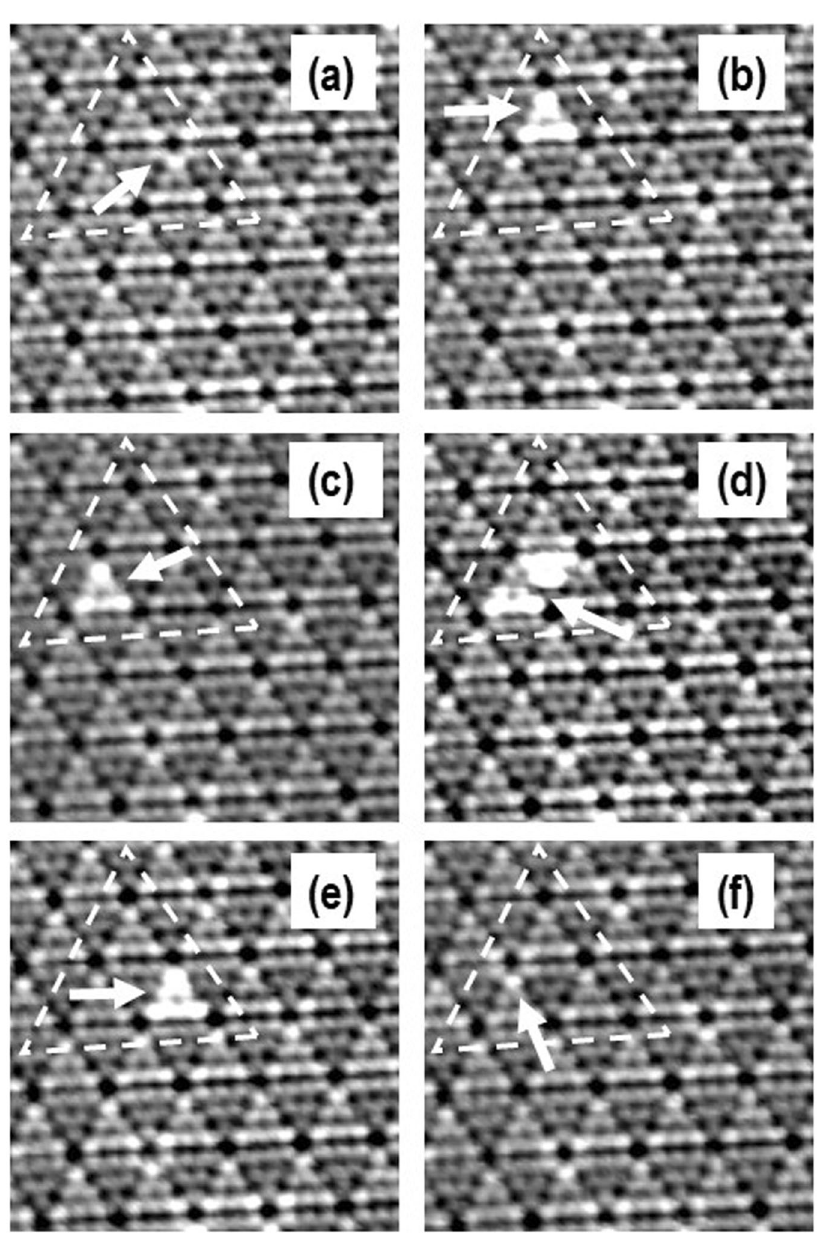
Fig. 3 Diffusion at 150 Celsius degrees. The set of six fi lled states STM images ( a – f ) separated by about 45 s of the same surface area (14×14 nm 2 , − 1.0 V, 166 nA) showing diffusing one Ag atom from one corner hole to the other corner hole through HUCs at about 150 Celsius degrees. The area of interests where diffusion of single Ag atom takes place is outlined by the triangular shape and diffusing atom is denoted by the arrow. In ( a ) Ag atom is in the CH. In ( b ) the Ag atom is in FHUC and in ( c ) the Ag atom is in FHUC. ( d ) Ag is in transition between FHUC and UHUC. In ( e ) the Ag atom is in FHUC. In ( f ) the Ag atom is in CH. In all the images we can see more CHs that are occupied with Ag atoms but during this process they stay unchanged. Original fi les in ( a – f ) are provided in Supplementary Data 2: ( a ) m112_ori.par, m112_ori.tf0, m112_ori.tb0. ( b ) m113_ori.par, m113_ori.tf0,